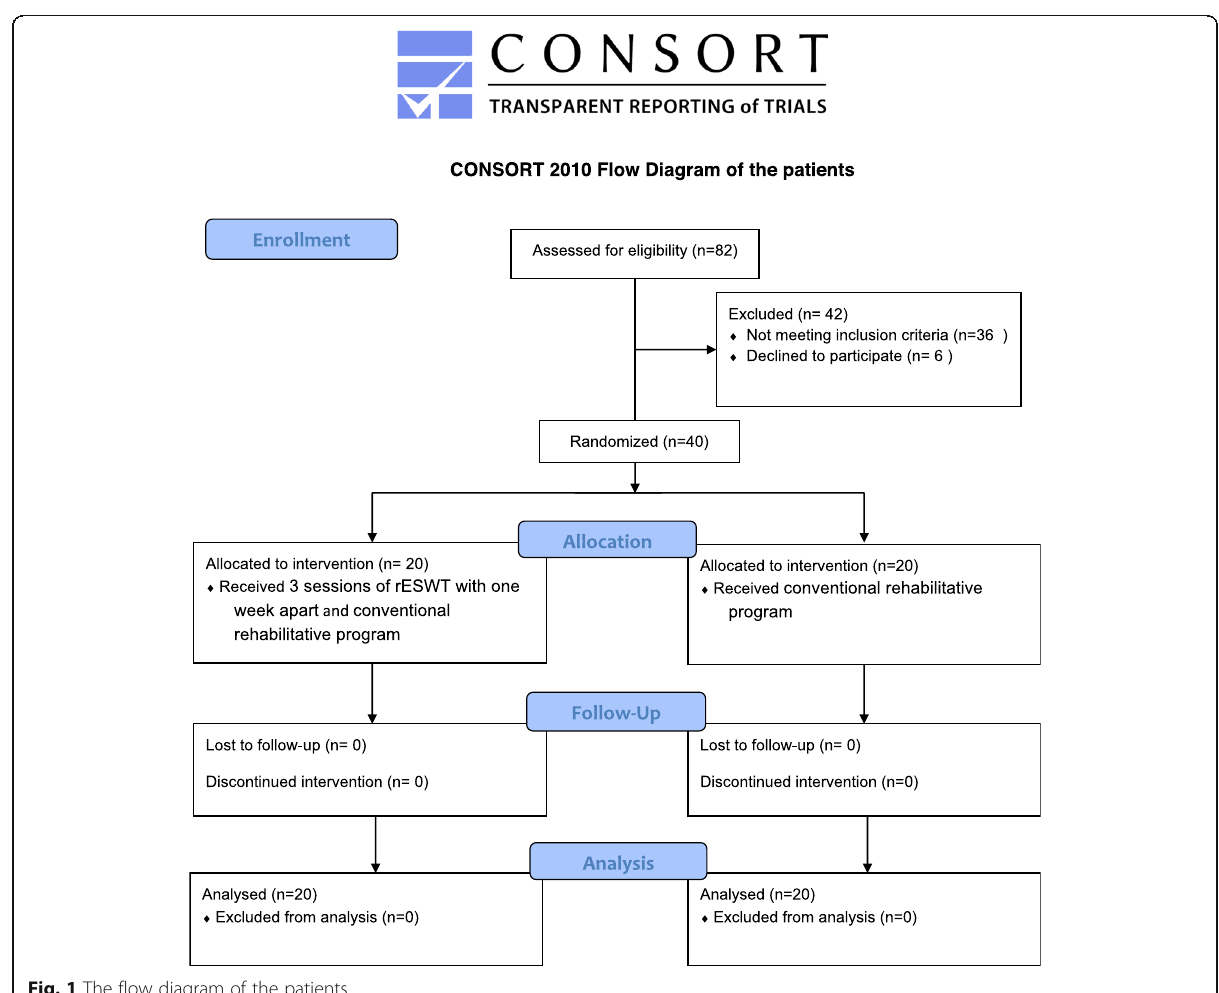
Fig. 1 The flow diagram of the